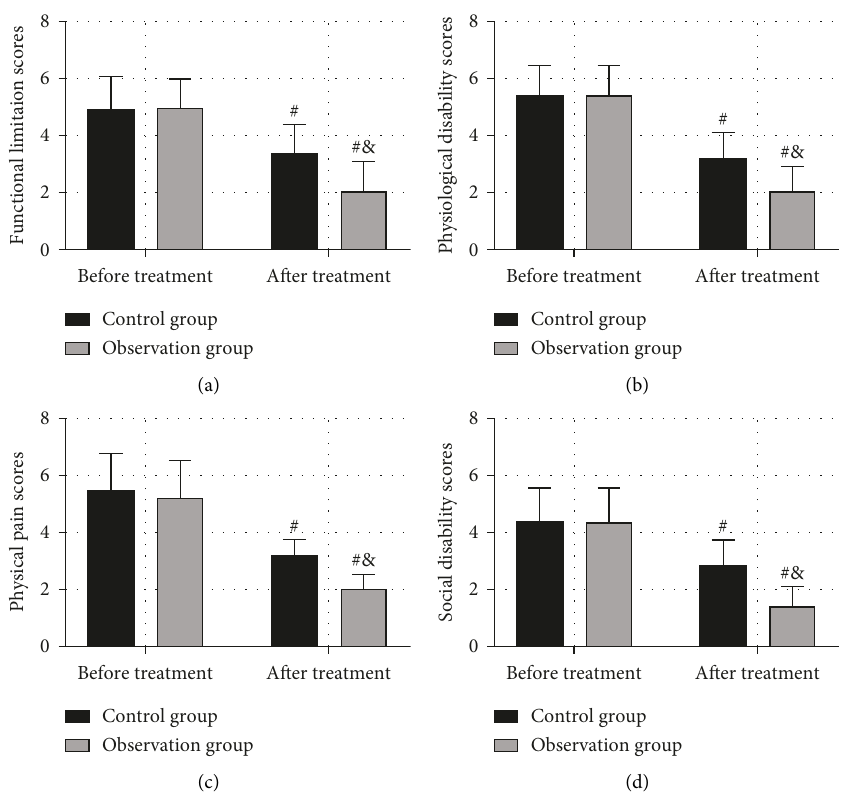
Figure 3: Comparison of oral health status. (a) Comparison of functional limitation scores between the research group and control group. (b) Comparison of physiological disability scores between the research group and control group. (c) Comparison of physical pain scores between the research group and control group. (d) Comparison of social disability scores between the research group and control group. Note. # indicates that the difference is statistically significant compared with that before treatment ( P < 0 . 05), and & indicates that the difference is statistically significant compared with the control group ( P < 0 .